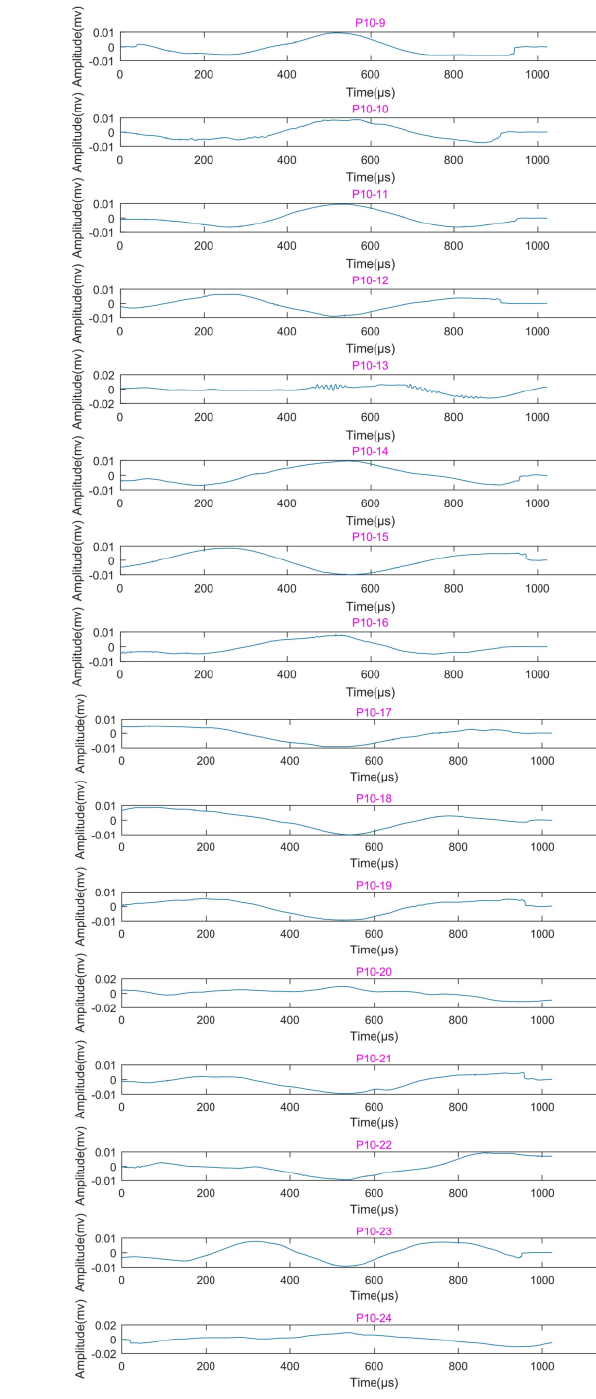
Figure 6. Reconstructed waveforms of AE signals with largest centroid frequency collected by sensors P7 and P10 in working cases 9–24 after wavelet decomposition and de-noising. The waveforms of sensors P7 and P10 for working case 13 (subpicture P7–13 and P10–13, respectively) contain high-frequency fluctuations, which indicates the initiation of ruptures in the tunnel arch foot.